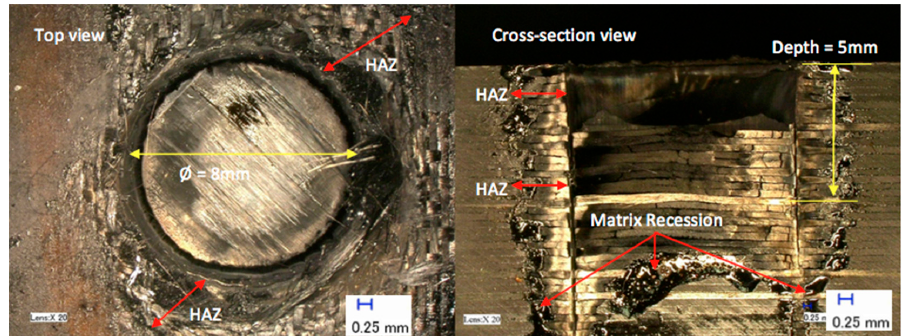
Figure 7. Typical example of a hole at a laser power of 600 W.